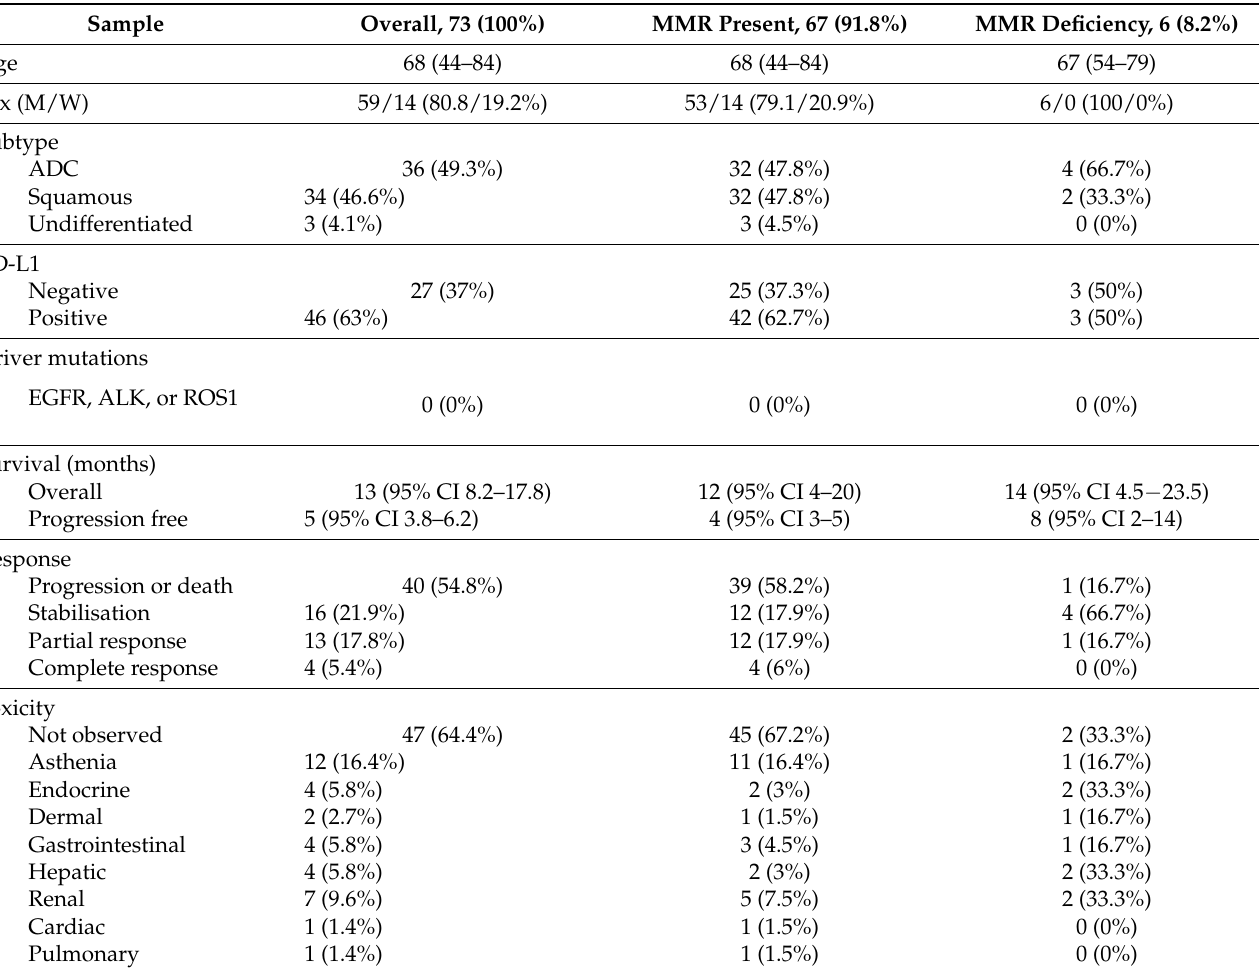
Table 1. General characteristics of the sample. The table shows the demographic variables of the study population of patients with advanced or metastatic NSCLC under treatment with immunotherapy at the Complejo Asistencial Universitario de